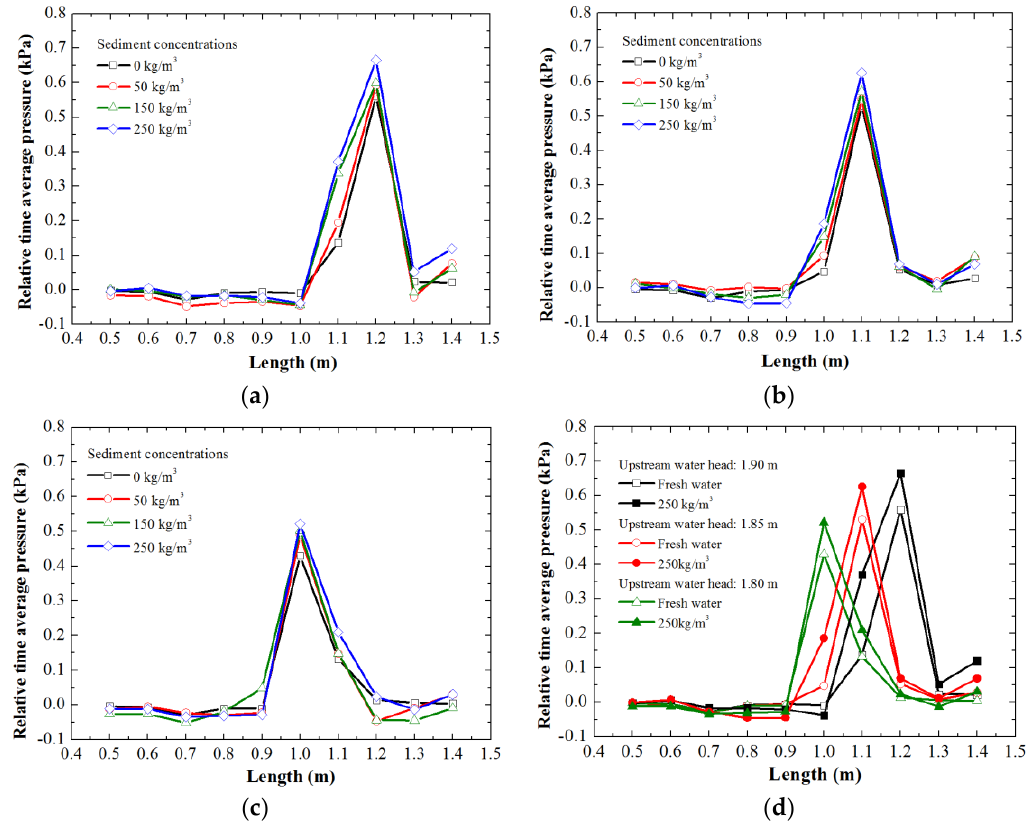
Figure 7. Time-averaged pressure and location for different upstream water heads at different concentrations of sediments: ( a ) Upstream water head of 1.9 m; ( b ) upstream water head of 1.85 m; ( c ) upstream water head of 1.8 m; ( d ) comparison of pressures at different upstream water heads due to fresh water and sediment-laden flow of 250 kg/m 3 in